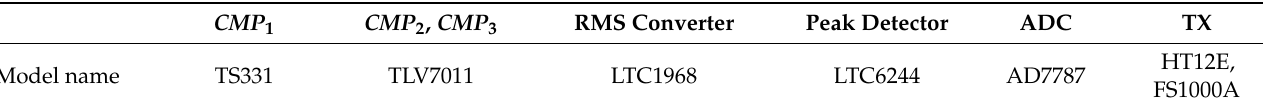
Figure 12. Experimental setup for the proposed system. ( a ) Prototype PCB and ( b ) experimental setup with PD signal as input. Table 2. Model name of each block of the proposed system.